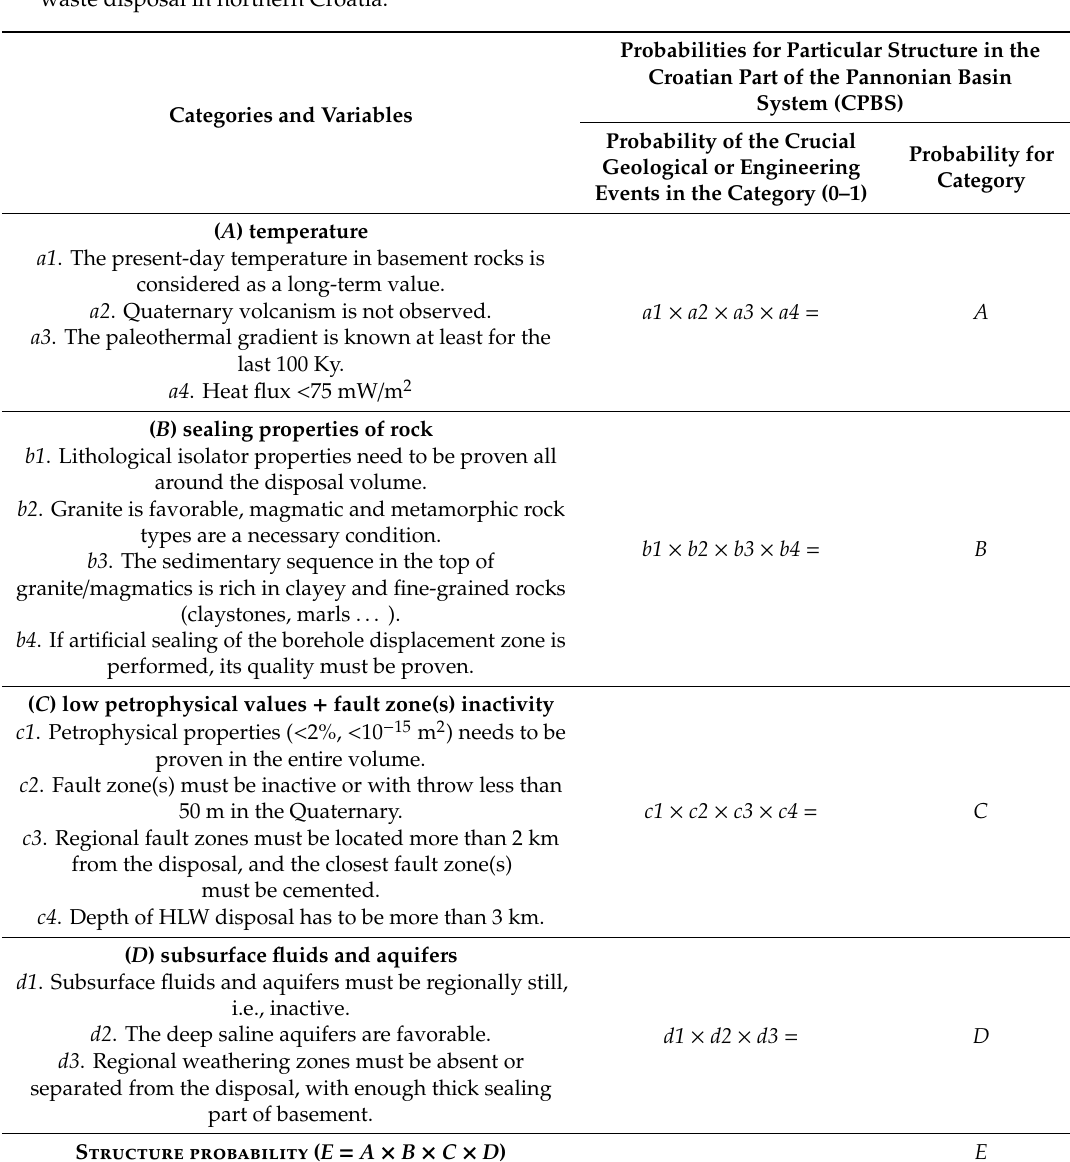
Table 2. Categories and variables selected for the modified PoS to potentially be applied for radioactive waste disposal in northern